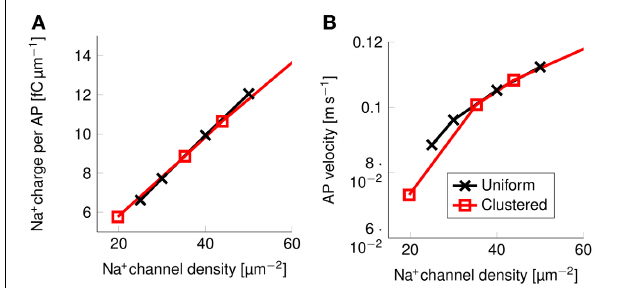
FIGURE 9 | Metabolic cost and action potential velocity as a function of Na + channel density in a 0.1 µ m diameter C-fiber axon. (A) Metabolic cost and (B) action potential velocity as a function of Na + channel density in both axons with uniformly distributed Na + channels (black) and axons with clustered Na + channels (red). Although the overall density of Na + channels clearly has an impact on both metabolic cost and velocity, there is no detectable effect from clustering Na + channels in lipid rafts.